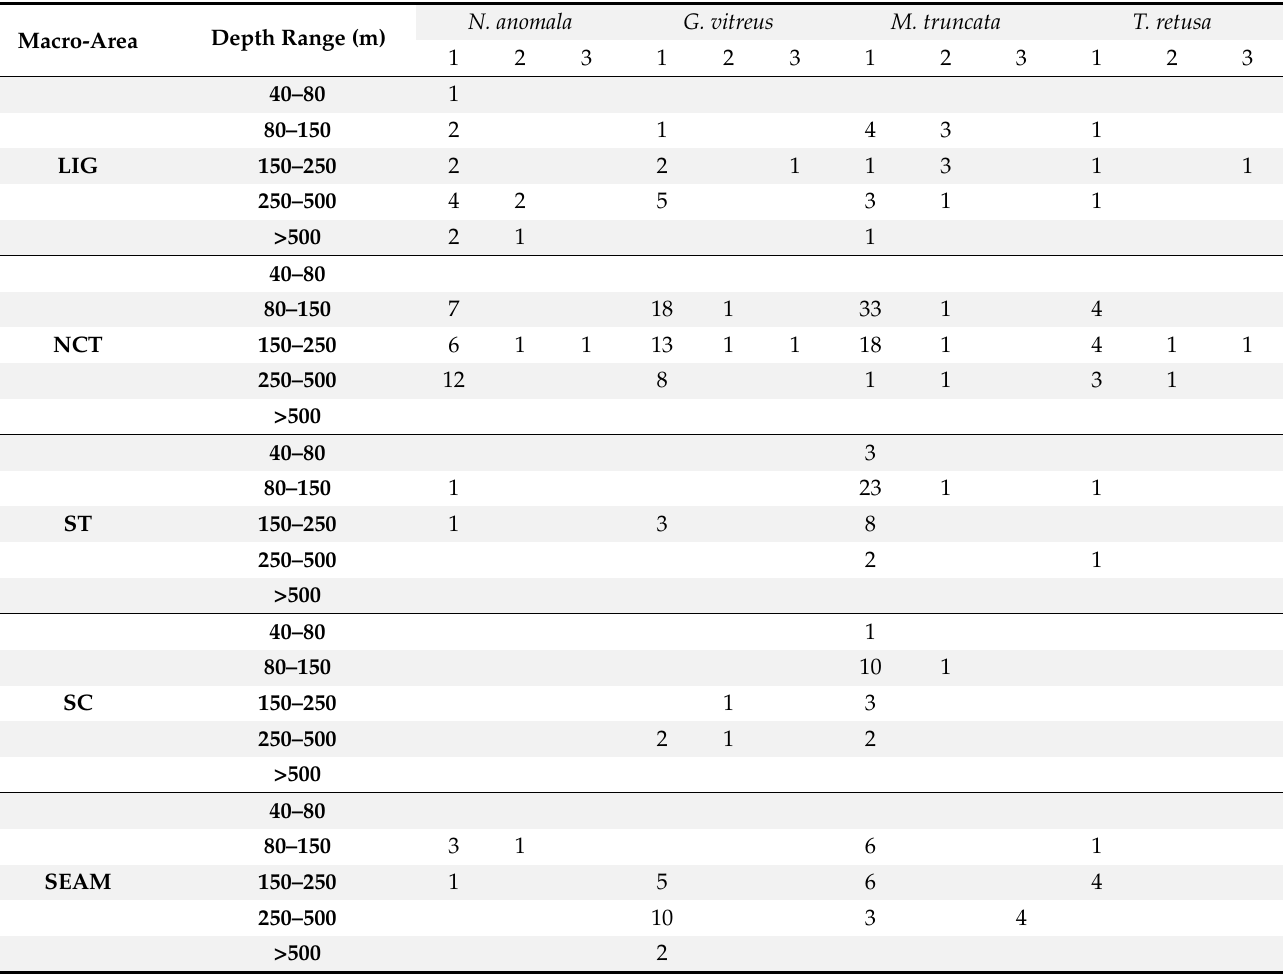
Table 2. List of the brachiopod species found in the present study. The number of sites in which each species was recorded per geographic area and depth range is given, together with indications of relative population densities. LIG, Ligurian Sea; NCT, North-central Tyrrhenian Sea; ST, southern Tyrrhenian Sea; SC, Sicily Channel; SEAM, seamounts. Population density: 1, rare; 2, common; 3, abundant. N. anomala G. vitreus M.